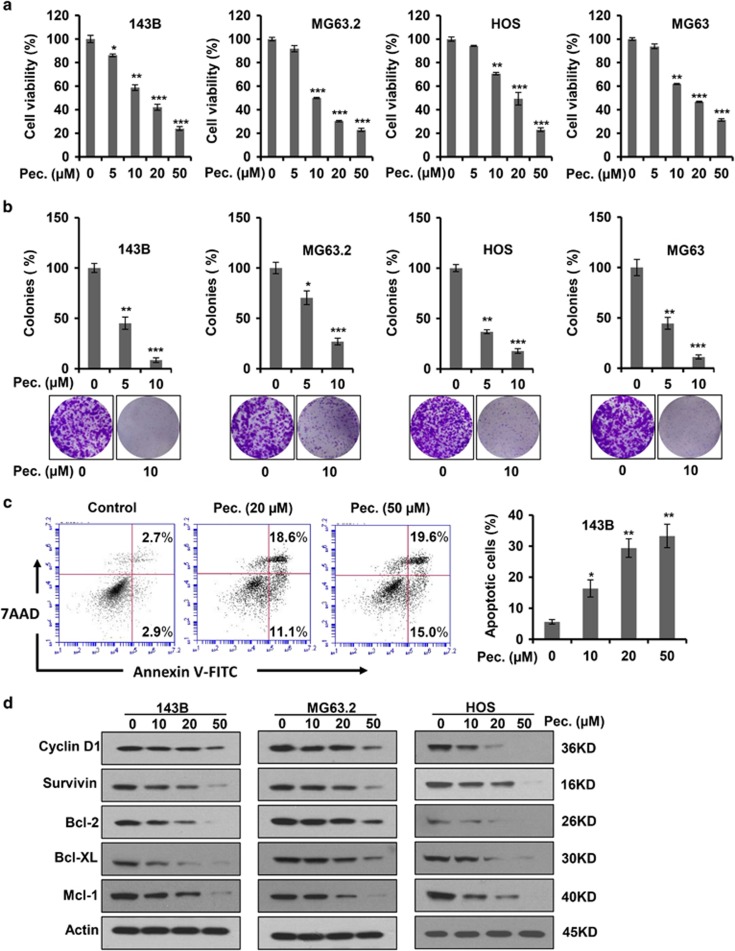
Pectolinarigenin inhibits osteosarcoma cells proliferation, colony formation, and induces apoptosis in osteosarcoma cell lines. (a) Osteosarcoma cells (143B, MG63.2, HOS and MG63) were treated with increasing concentrations of pectolinarigenin for 48 h and a MTS assay was performed (**P<0.01; ***P<0.001). (b) Osteosarcoma cells were seeded into six-well plates and treated with or without 10 μM pectolinarigenin for a week. Colonies were then fixed and stained with 0.1% crystal violet. Images were taken by an invert microscope (Leica). Colony numbers were counted manually (*P<0.05; **P<0.01; ***P<0.001). (c) 143B cells were treated with pectolinarigenin at the indicated doses for 48 h. Apoptotic cells were labeled with Annexin V and PI and analyzed by flow cytometry (*P<0.05; **P<0.01). (d) A western blot assay was used to detect the protein level of STAT3 target genes after pectolinarigenin exposure